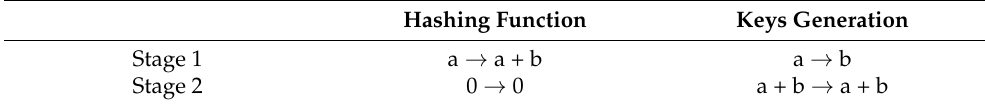
Table 6. Difference conversion scheme for the HBC-256 hashing